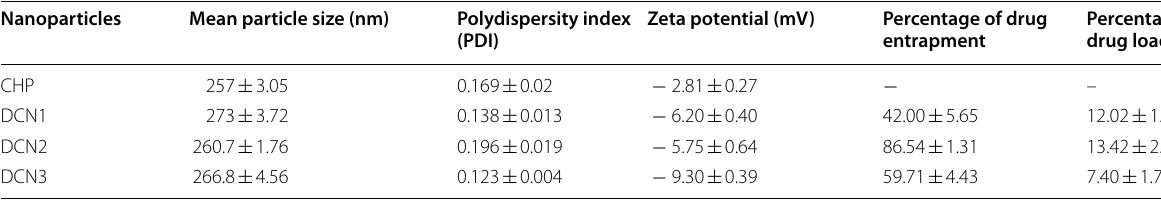
Table 1 Characteristics of nanoparticles